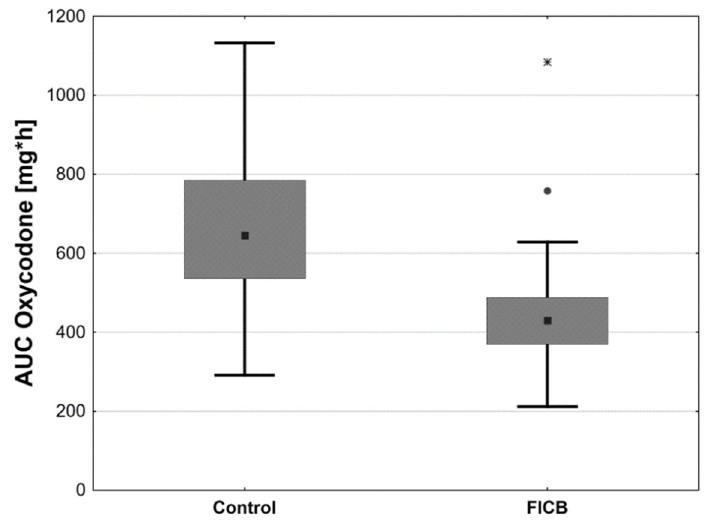
Figure 4. Box plot of oxycodone AUC in the control and FICB group.